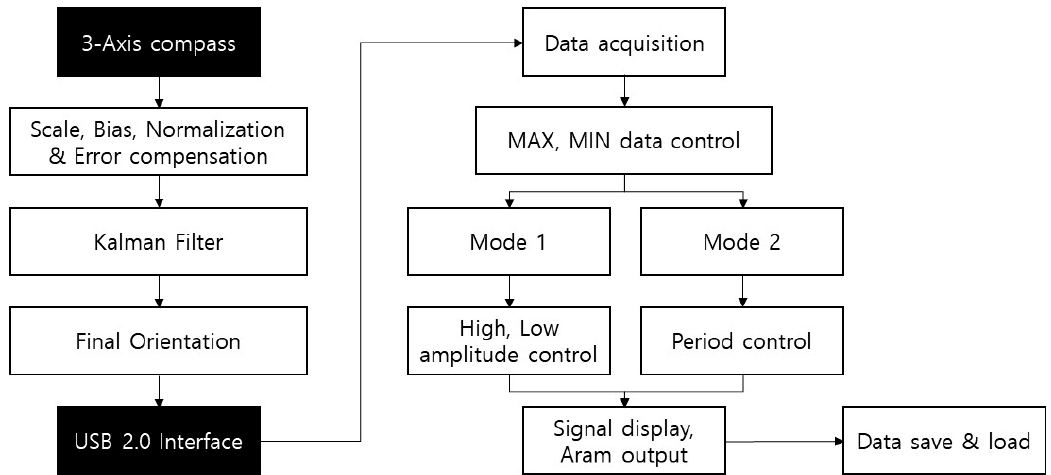
Figure 2. MEMS magnetic field sensor-based respiratory monitoring and training process.